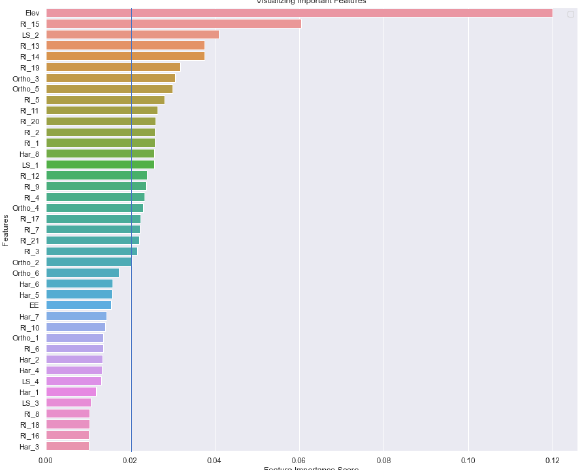
Figure 5. Importance analysis with Gini criterion for the pixel- based classification.